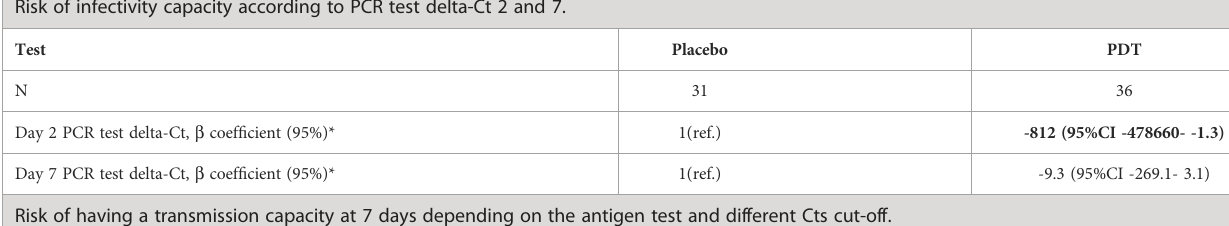
TABLE 2 Risk of infectivity capacity according to PCR test delta-Ct at days 2 and 7. Risk of infectivity capacity according to PCR test delta-Ct 2 and 7.